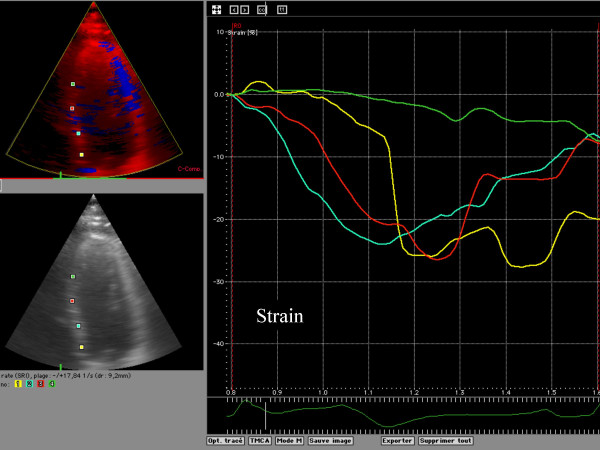
Example of Strain analysis; It was there possible to record the degree of systolic shortening or lengthening of the 4 studied ROI.